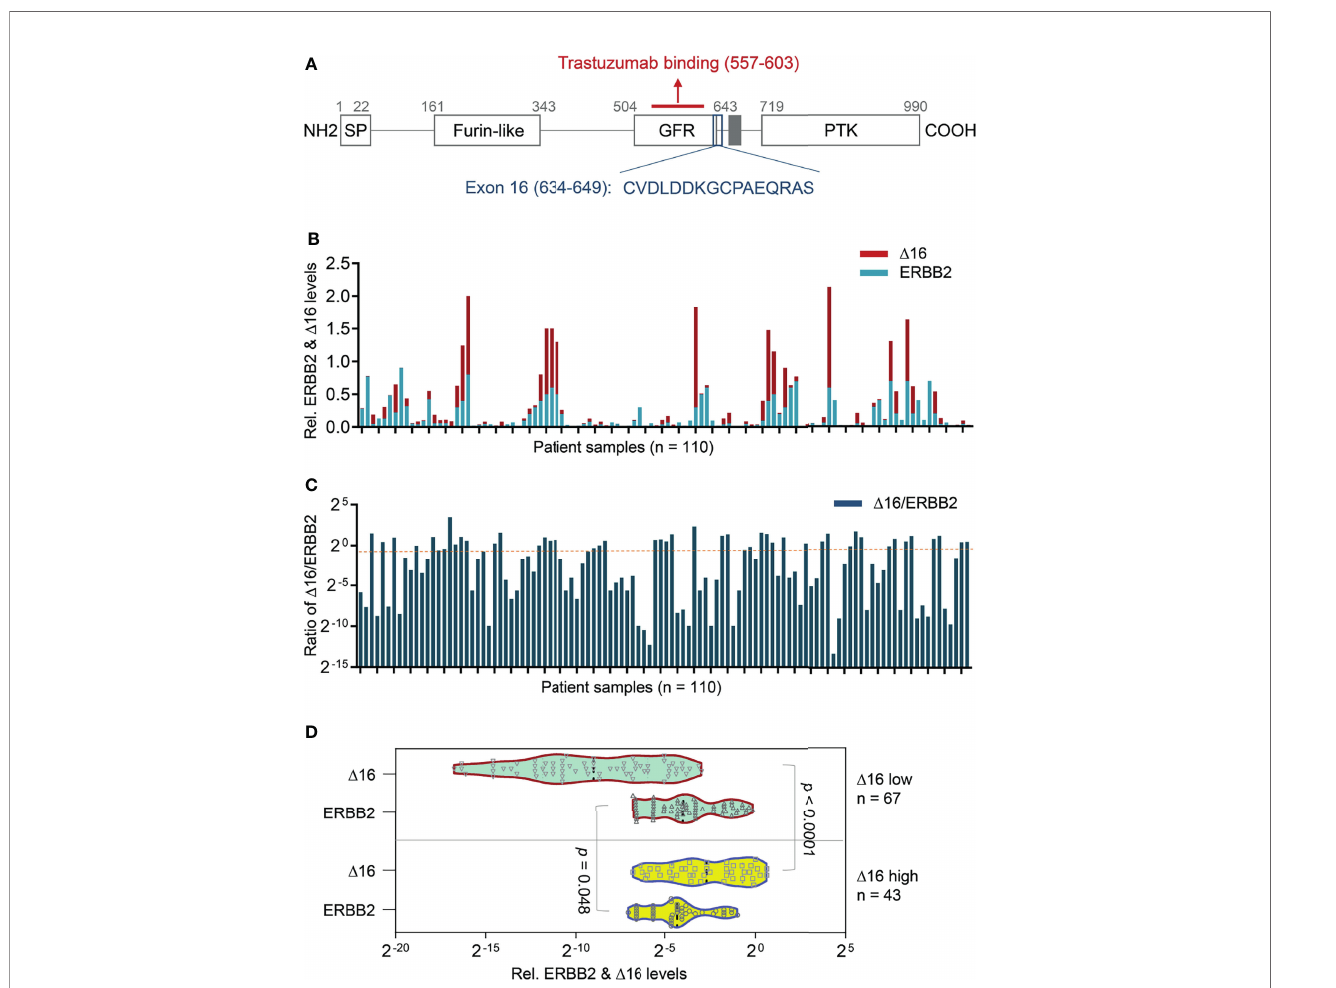
FIGURE 1 | Transcriptional expression of ERBB2d16 and ERBB2 in gastric cancer. (A) The schematic structure of the ERBB2d16 protein; (B) The transcriptional expression of ERBB2 and ERBB2d16 by quantitative RT-PCR in gastric cancer tissue with beta-actin as an internal control (n = 110); (C) The ratios of the ERBB2d16/ERBB2 in HER2-positive gastric cancer tissues (n = 110). (D) An ERBB2d16/ERBB2 ratio-dependent expression pattern of ERBB2d16 relative to ERBB2 expression. D 16 low: ERBB2d16/ERBB2 ratio < 0.88; D 16 high: ERBB2d16/ERBB2 ratio ≥ 0.88. ERBB2: human epidermal growth factor receptor-2; ERBB2d16: ERBB2 D Ex16; RT-PCR: reverse transcriptive polymerase chain reaction